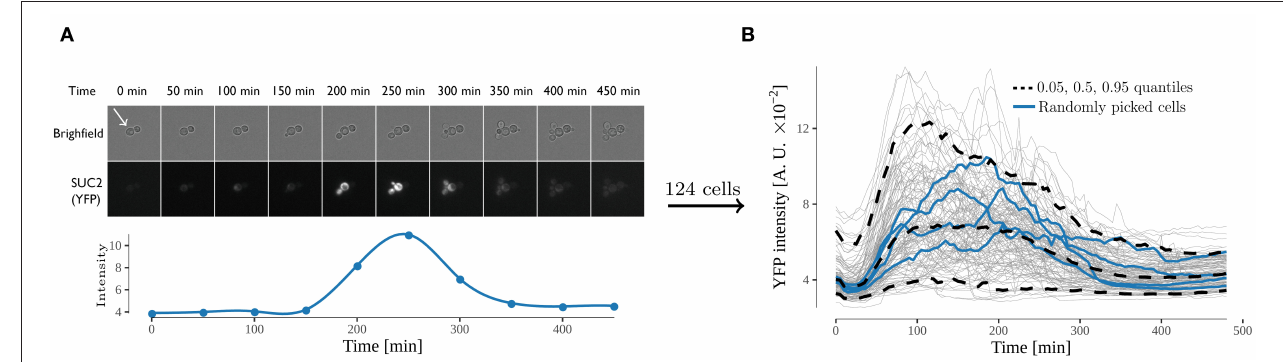
FIGURE 2 | Expression from the SUC2 promotor over time, expressed as fluorescence intensity of YFP divided by area. (A) time-lapse images of cells exposed to shift from high (4%) to low (0.1%) glucose. Both bright field and yellow fluorescence images are displayed. Below is the intensity over time of one cell (annotated by white arrow). The fluorescence intensity was observed for 480 min with an interval of 5 min between every image acquisition. (B) Fluorescence intensity over time of all analyzed cells. Each gray line represents the trace of one single cell, and the 0.05, 0.5, and 0.95 quantiles of the cells are represented with a dashed black line. Four randomly selected cells are represented with a blue line. 124 cells were analyzed in the experiment.